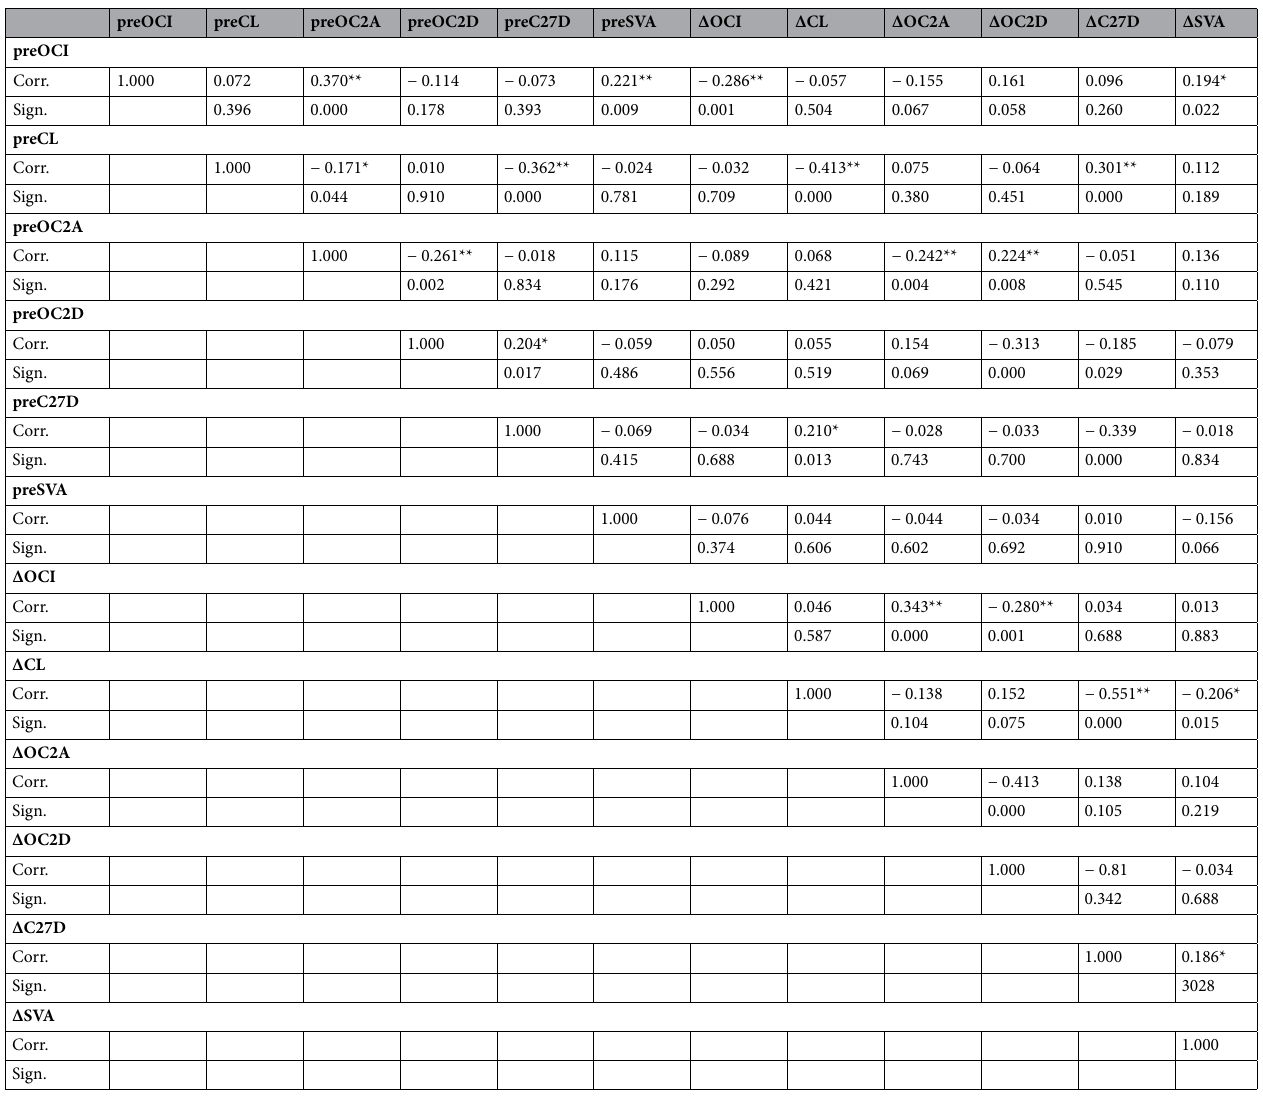
Table 3. Correlation between preoperative parameters and Δ values of each parameter. Pre, preoperative; Δ, postoperative value–preoperative value; Corr., correlation efficient, Sign., p -value. *: p -value < 0.05, **: p -value <